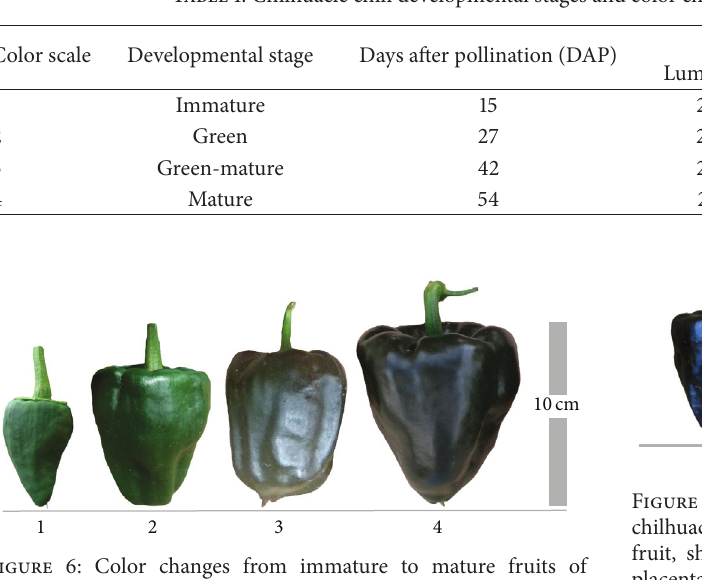
Figure 5: Development of the chilhuacle chili fruit. The fruit develops 7 days after pollination [DAP]. At the beginning of fruit development, the calyx covers a substantial portion of the outside of the fruit (15 DAP). Subsequently, the fruit acquires an elongated form, with a thick peduncle (20 to 27 DAP). When the fruit has achieved its final size and shape, the color is black or very deep purple and the calyx is immersed in the fruit (42 to 54 DAP). Developed fruits can be harvested between 60 and 78 DAP. Table 1: Chilhuacle chili developmental stages and color changes from immature to mature fruits.